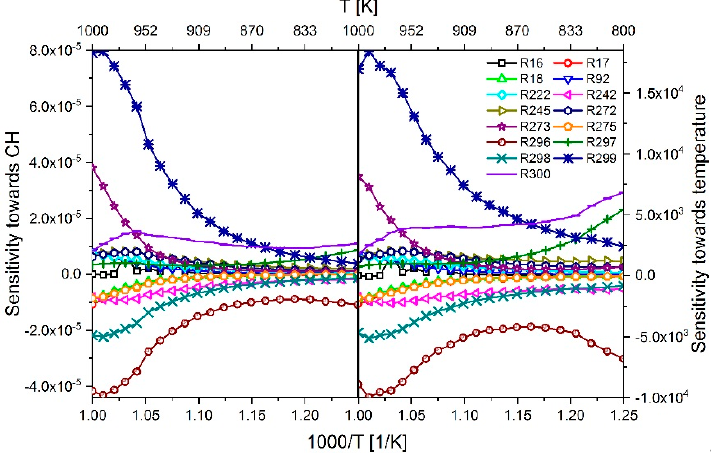
Figure 15. Comparison of sensitivity towards species CH (left) and sensitivity toward temperature (right) simulated with an n -heptane–air mixture at φ = 1 and p = 60 bar.